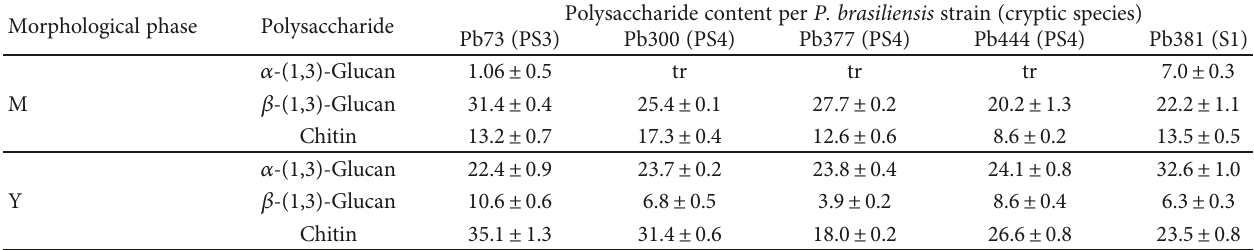
Table 1: Relative content of the main polysaccharides present in the yeast cell wall of di ff erent strains of Paracoccidioides brasiliensis . Strains belonging to at least three di ff erent cryptic species were grown at 37 ° C on RPMI 1640 (Gibco) liquid medium, bu ff ered with